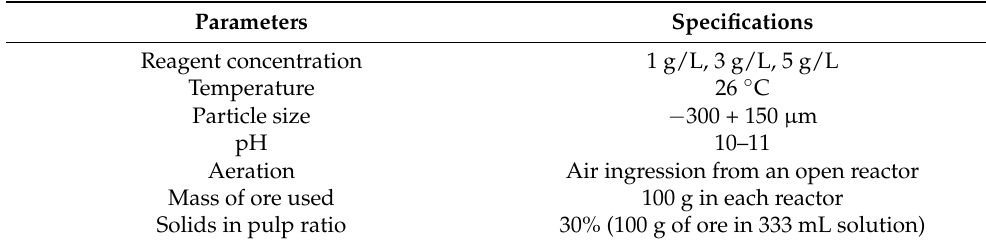
Table 2. Cyanide leaching experiment